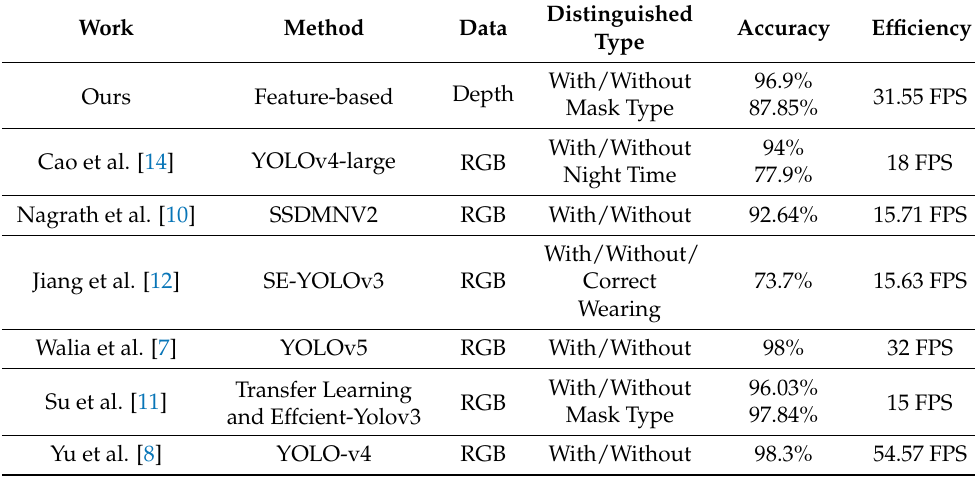
Table 3. Comparison of this proposal with other